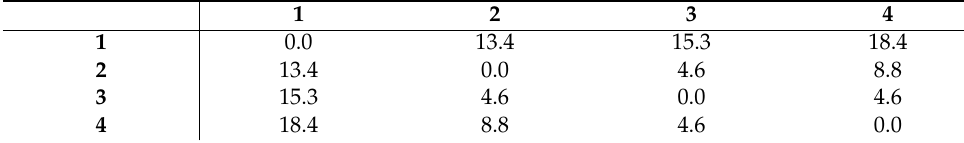
Table 6. Effort matrix E 5 for route